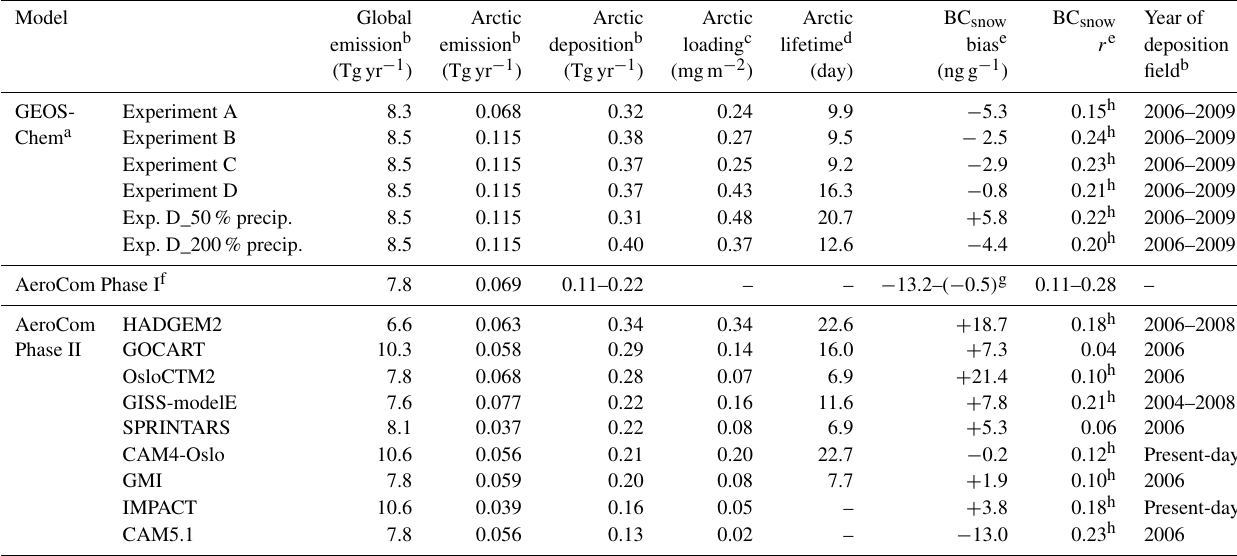
Table 6. Model simulations of BC in the Arctic (60 to 90 ◦ N). Model